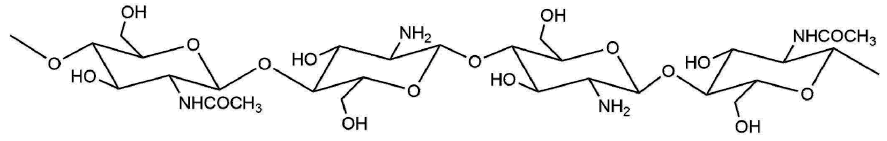
Figure 7. Chemical structure of chitosan.